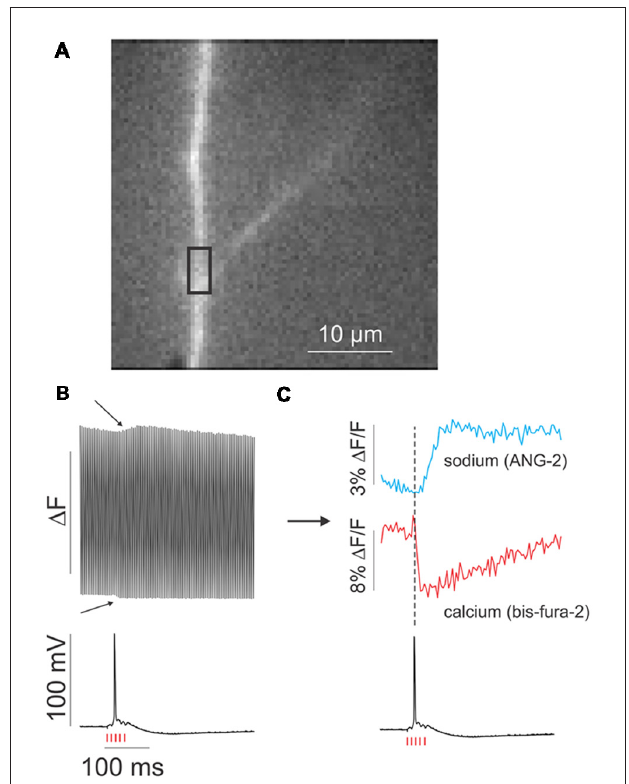
FIGURE 2 | Quasi-simultaneous detection of [Ca 2 + ] i and [Na + ] i changes in a dendrite in response to synaptic stimulation. (A) Fluorescence image of a small region of an apical dendrite of a rat CA1 pyramidal neuron. A region of interest (ROI) is marked with a black rectangle. (B) Simultaneous fluorescence response in the ROI and the somatically measured electrical response to a train of five synaptic stimuli at 100 Hz (red hash marks). The fluorescence response switches with each frame, which are excited at alternate wavelengths. The two “bumps” (arrows) correspond to the changes in [Ca 2 + ] i and [Na + ] i in response to the stimulation. (C) Sodium and calcium signals after separating alternate frames. The calcium transient is matched to the action potential, while the sodium signal is delayed slightly. The calcium signal goes down because bis-fura-2 fluorescence decreases in response to an increase in [Ca 2 + ] i . Adapted from Miyazaki and Ross